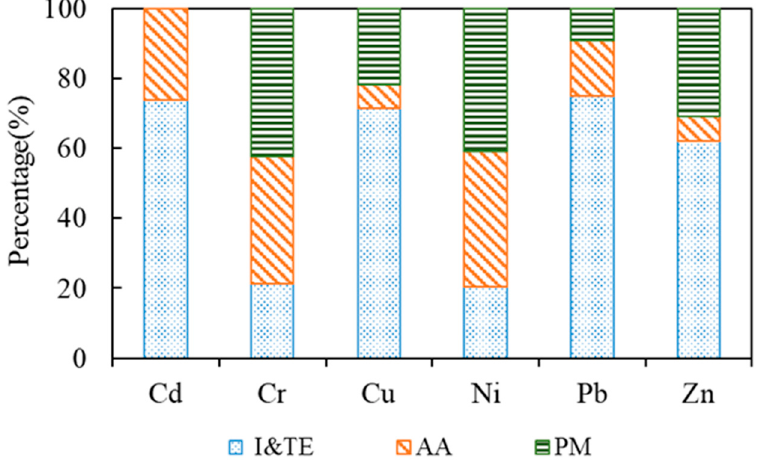
Figure 3. Relative source contributions to the heavy metals analyzed in the present study. I&TE, AA, and PM represent industrial and vehicular emissions, agricultural activity, and parent materials, respectively.